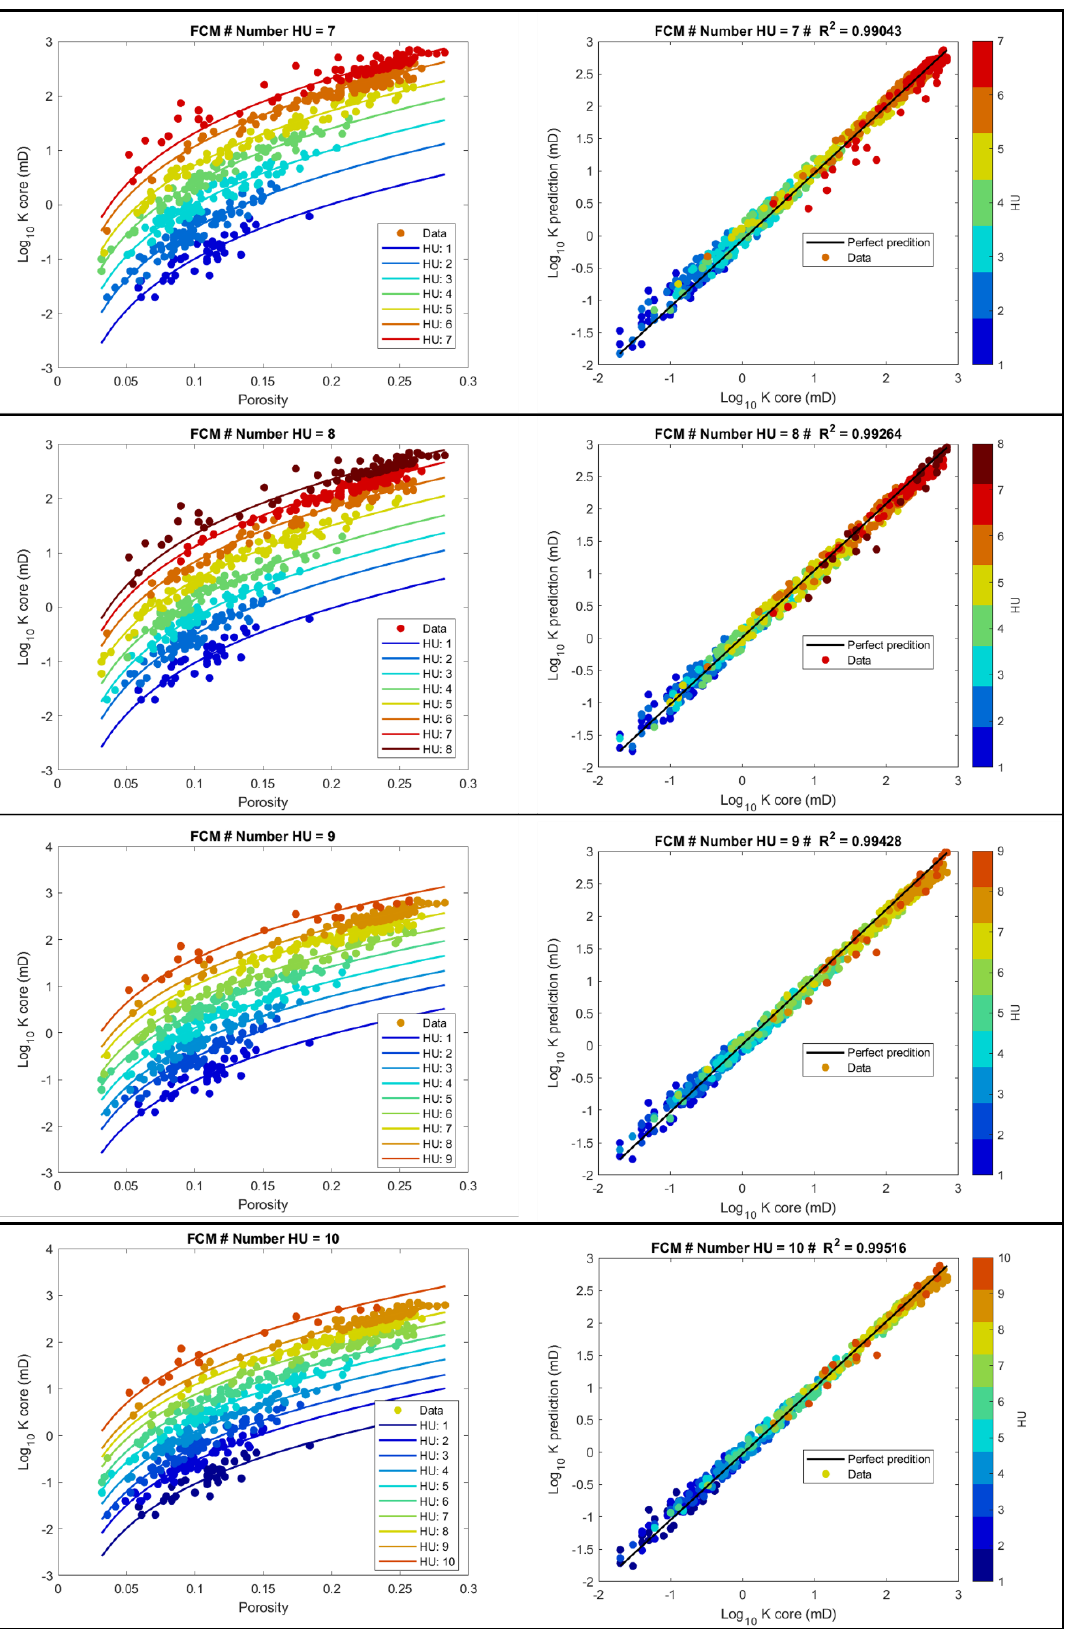
Figure 8. ( a ) The result of applying the FCM method to HU clustering: The cross plot of (K_core vs. PHI_core) and (K_core vs. K_pre) with different HU groups and ranging from 3 – 6 HU. ( b ) The result of applying the FCM method to HU clustering: The cross plot of (K_core vs. PHI_core) and (K_core vs. K_pre) with different HU groups ranging from 7 – 10 HU.